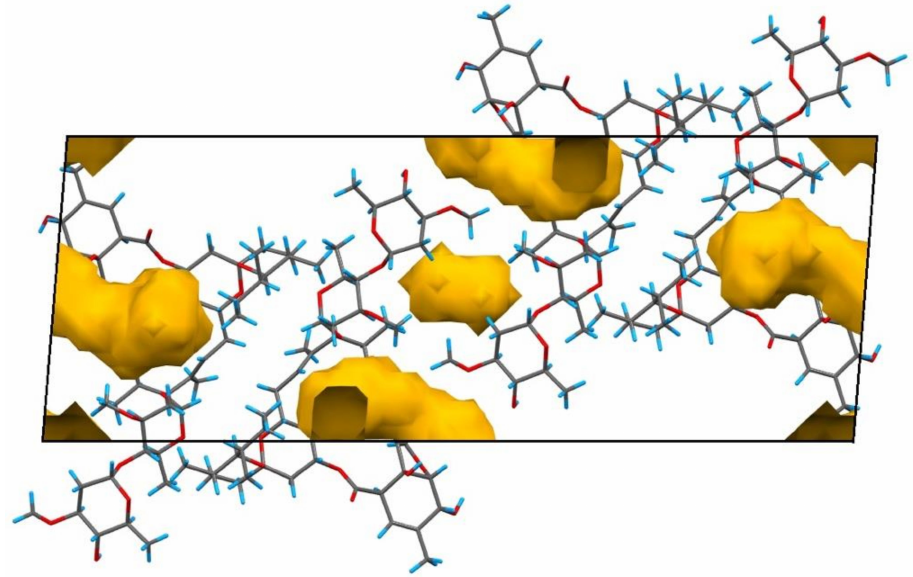
Figure 4. A projection of the unit cell of crystal I along the monoclinic axis showing the